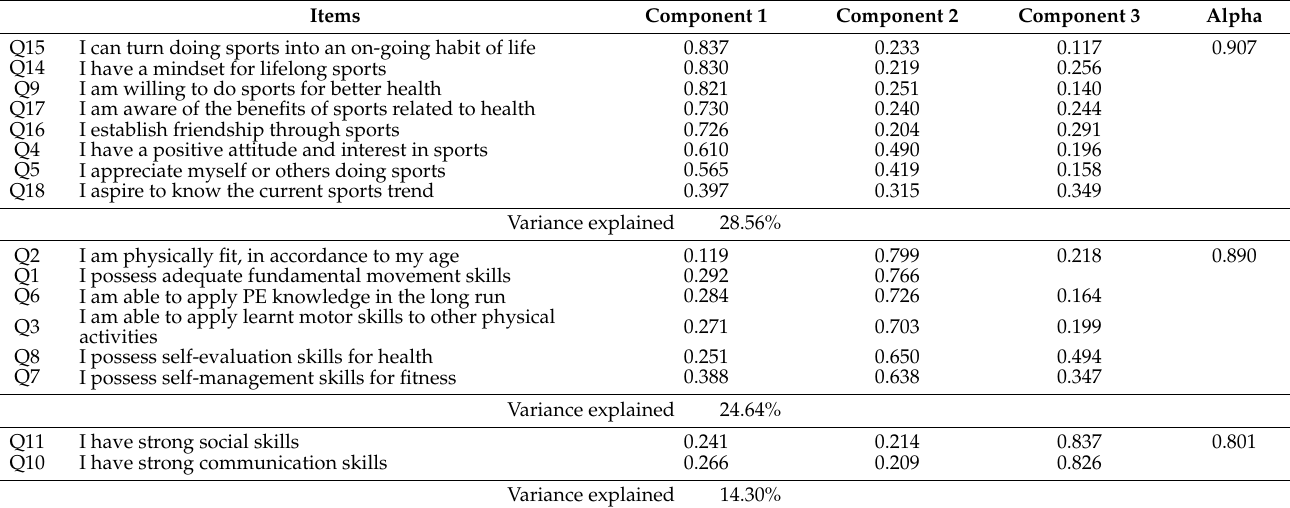
Table 2. Initial factor structures by exploratory factor analysis ( n = 238).